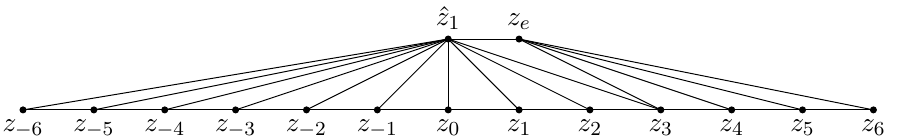
Figure 4 . The toric fan of the ambient toric variety projected onto the x 1 = 2 , x 2 = 3 plane with a given triangulation. In the diagram z fiber S over [0 : 1] ∈ f P 1 is S = S